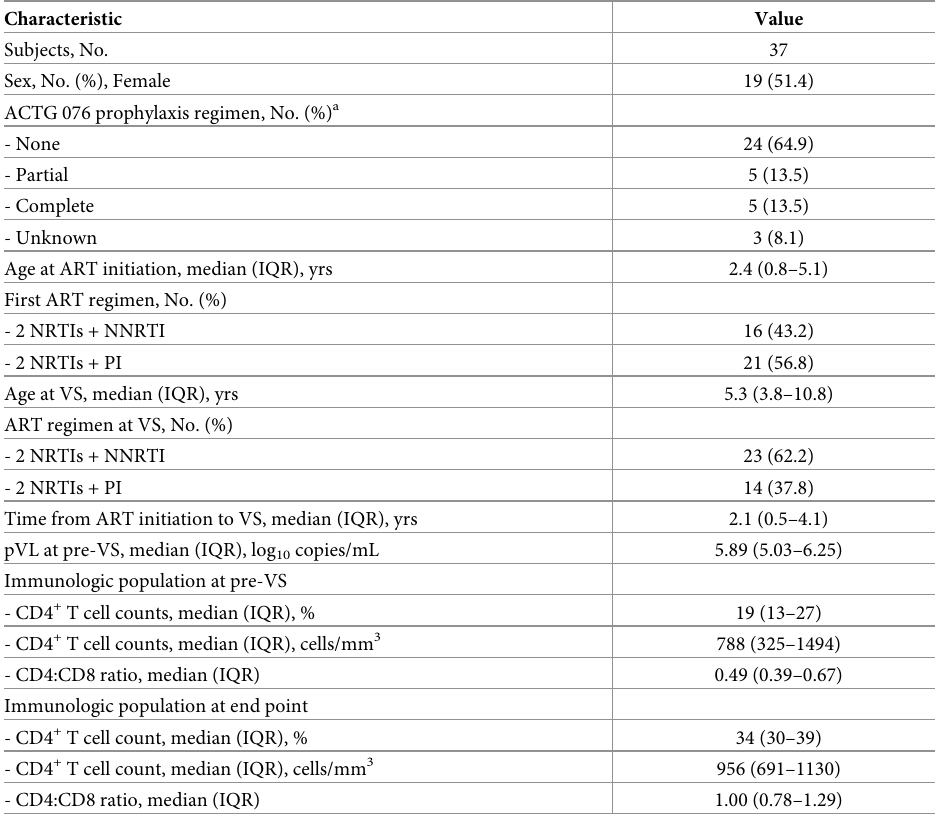
Table 1. Patient